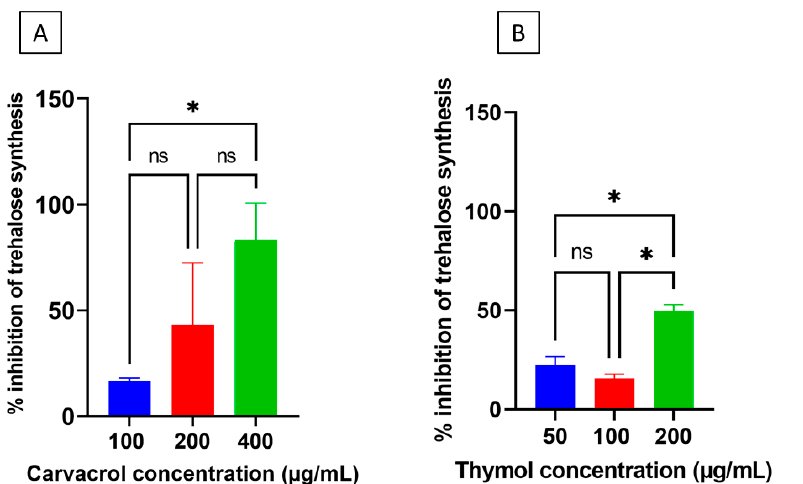
Figure 7. Inhibition of trehalose biosynthesis (per cent) in desiccation-adapted Salmonella Tennessee E2007000304 after treatment with different concentrations of carvacrol (panel ( A )) or thymol (panel ( B )) for 12 h at 22–25 °C. Each data point represents mean ± standard deviation. Asterisk (*) denotes significant difference at p < 0.05. “ns” denotes non-significant (i.e., p > 0.05)